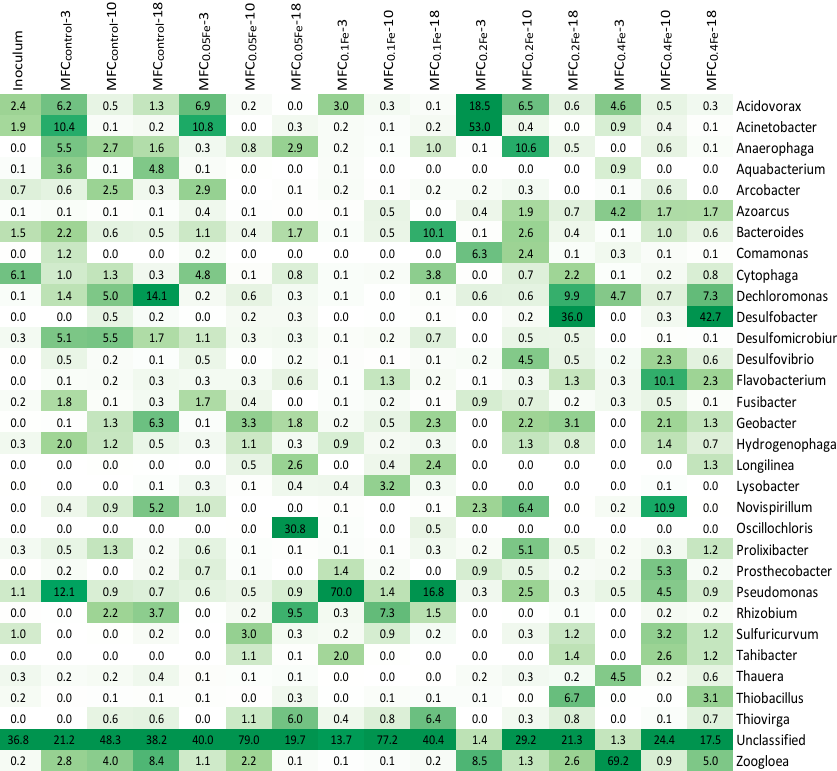
Figure 7. Heatmap showing 30 of the most numerous genera in the investigated MFCs, the number after the reactor name indicates the cycle in which sampling was performed.